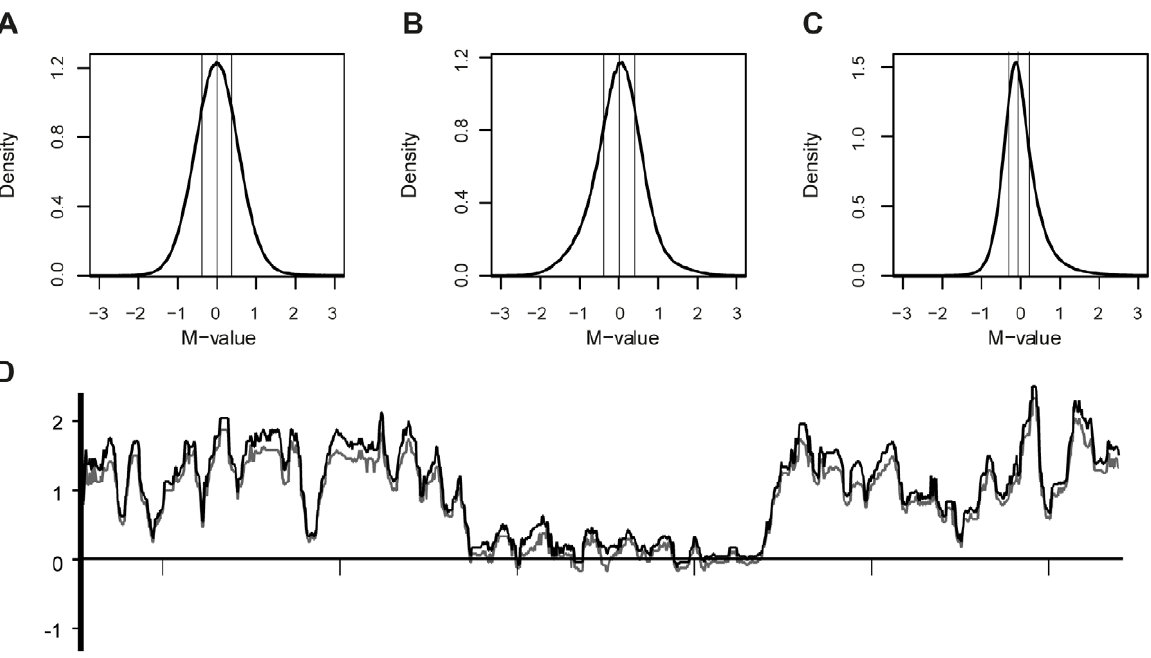
Figure 3. Visual inspection and normalization of ChIP-chip experiments. Visual inspection of three ChIP-chip experiments; (A) E(z), (B) H3K27me3 and (C) PolII. The estimated density functions (using the R-function density with the default bandwidth) of the observed M-values obtained after standard quantile normalization are shown. Vertical lines indicate first quartile, median and third quartile. (D) HMM-assisted normalization of H3K27me3 data. M-values after standard quantile normalization (grey) and HMM-assisted normalization (black). 10 Kb intervals are marked on the x-axis.